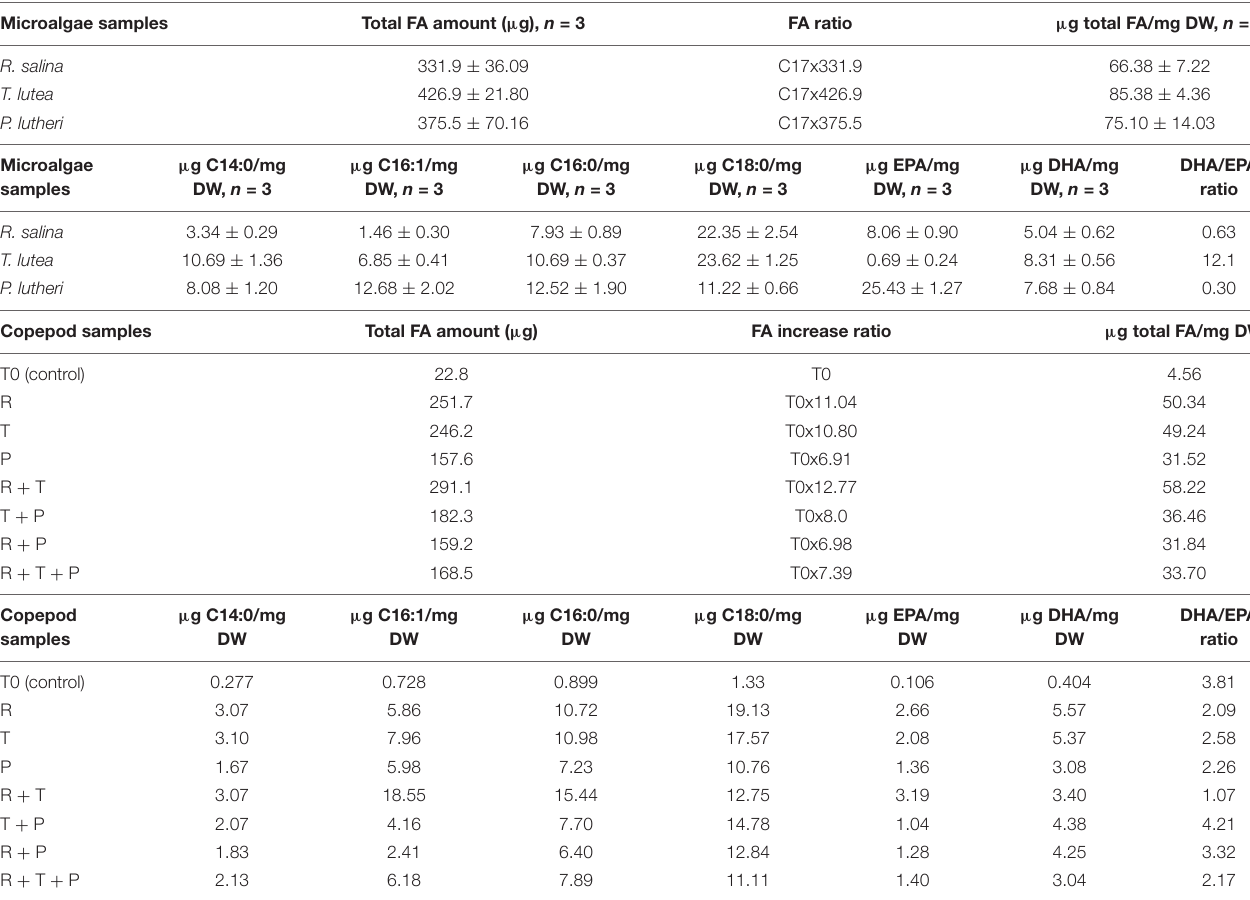
TABLE 1 | Total fatty acid amounts and respective EPA and DHA contents in each copepod and microalgae lyophilized sample. Microalgae samples Total FA amount ( µ g), n = 3 FA